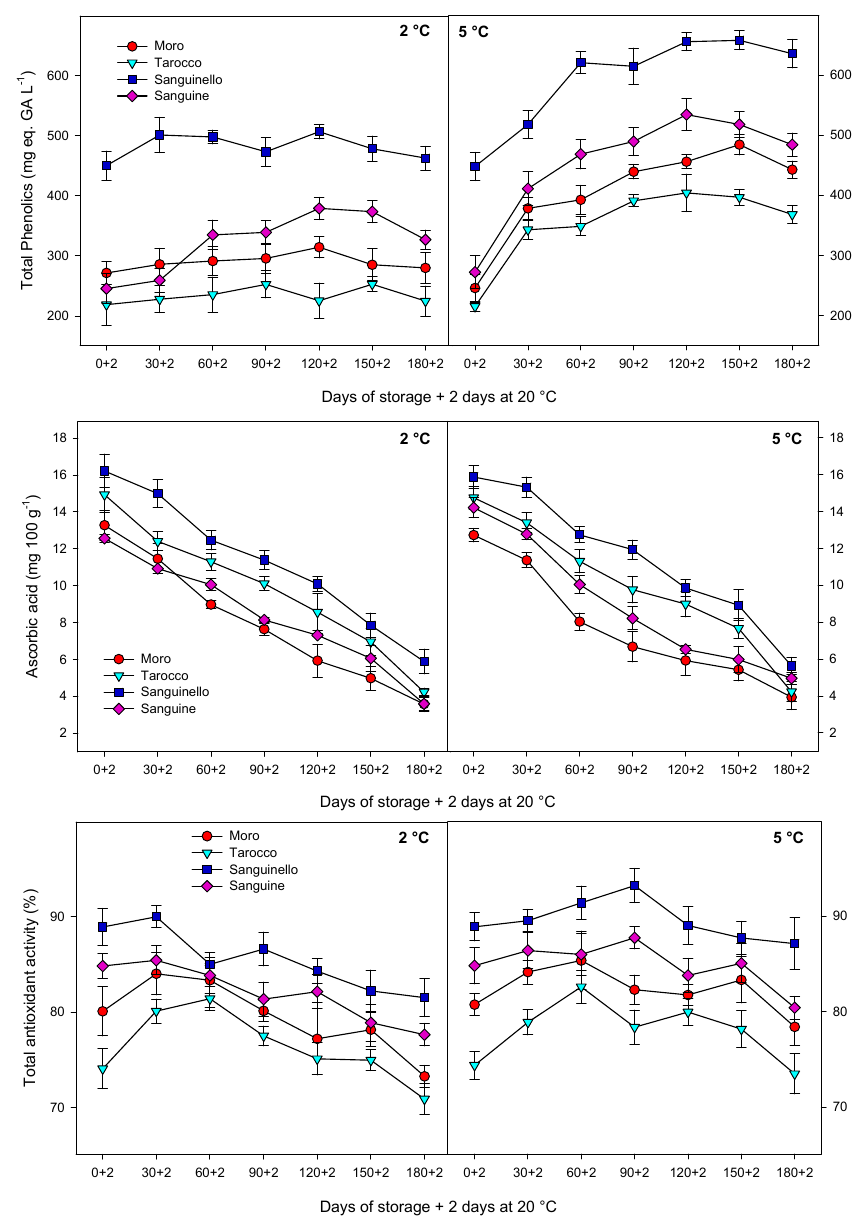
Figure 4. Changes in total phenolics, ascorbic acid, and total antioxidant activity of blood orange cultivars (“Moro”, “Tarocco”, “Sanguinello”, and “Sanguine”) stored at 2 and 5 ◦ C for 180 days plus 2 days at 20 ◦ C. Vertical bars represent ± standard error (SE) of means. LSD ( p < 0.05) values are 31.55, 0.44, and 4.29, for total phenolics, ascorbic acid, and total antioxidant activity, respectively.